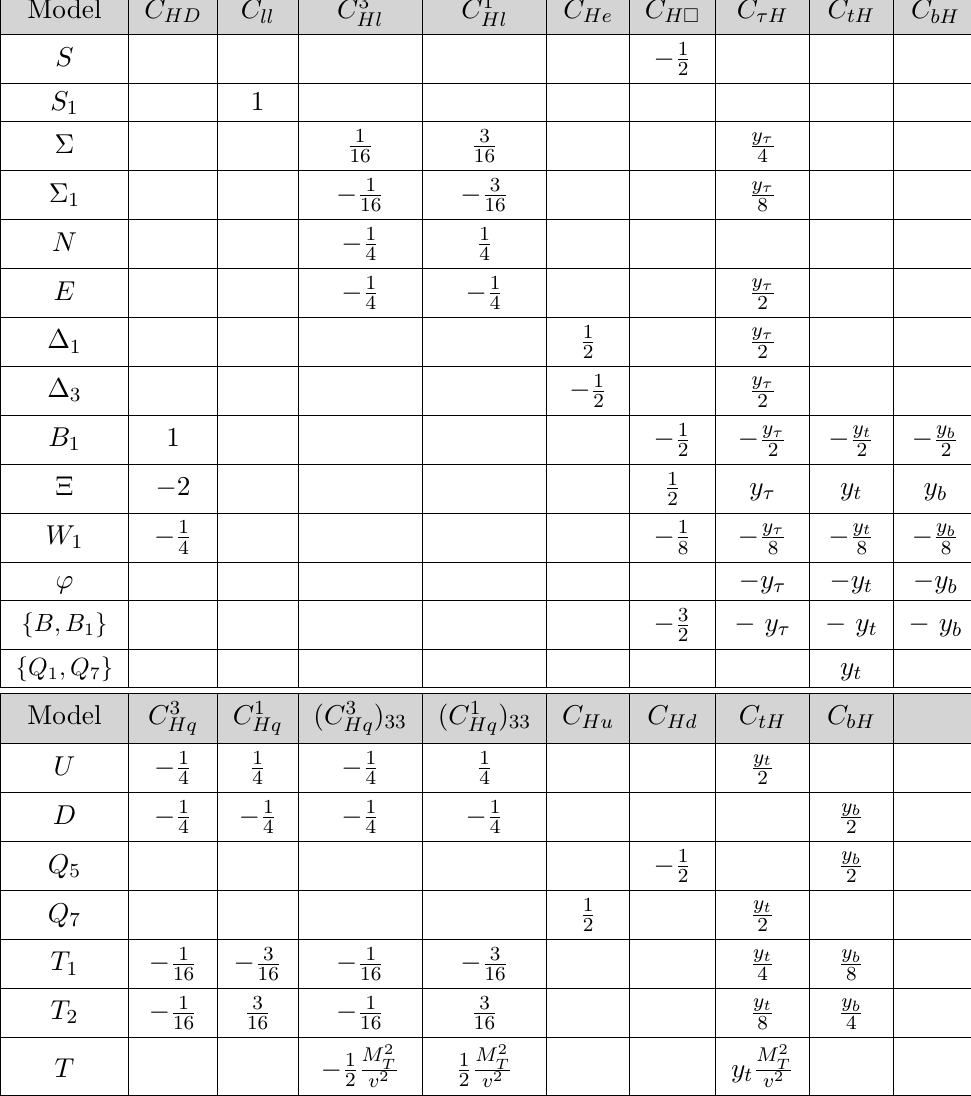
Table 4 . Operators generated at tree level by the single-field extensions listed in the first column. Each extension depends on a single coupling (see table 3) as well as a new physics mass-scale M . The coefficients of the operators are each proportional to the squares of the corresponding coupling λ by the corresponding entry in the table and divided by M 2 . y t , y b and y τ denote the top, bottom and tau Yukawa couplings respectively, v denotes the electroweak scale and α strong